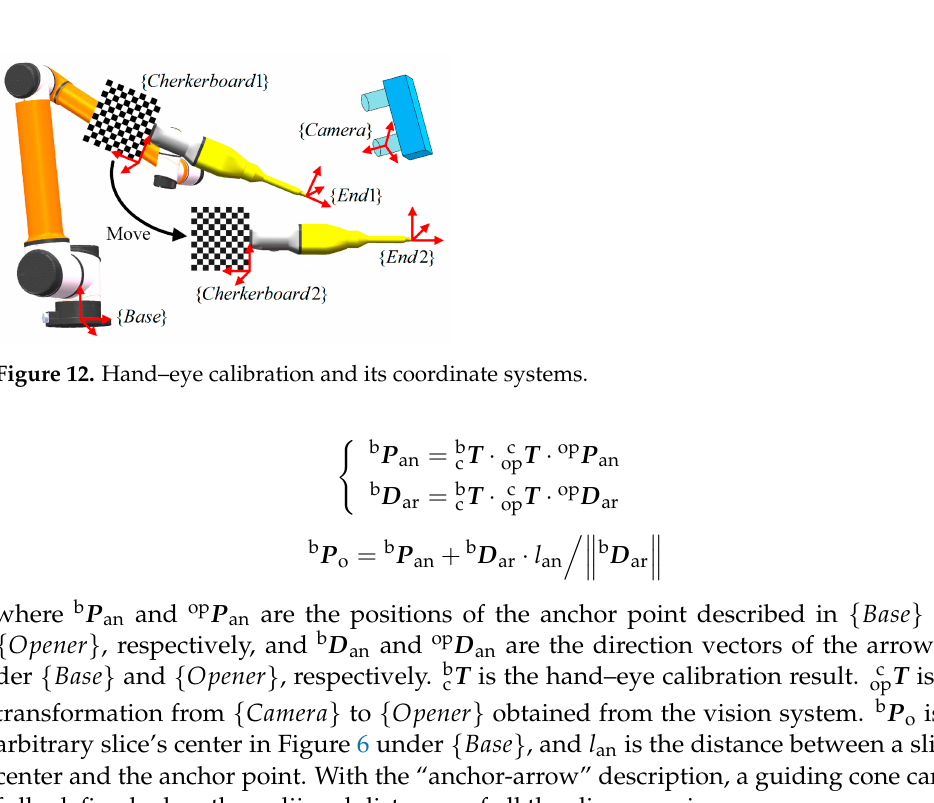
arbitrary slice’s center in Figure 6 under { Base } , and l an is the distance between a slice’s center and the anchor point. With the “anchor-arrow” description, a guiding cone can be fully defined when the radii and distances of all the slices are given.